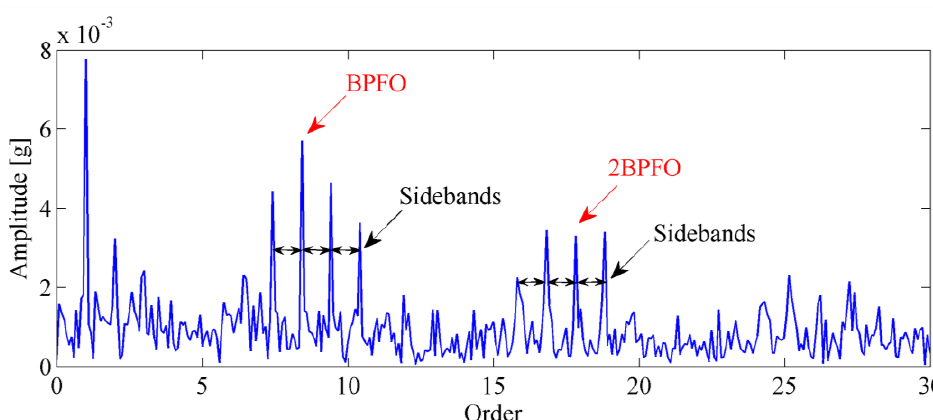
Figure 16. The envelope order spectrum obtained by proposed